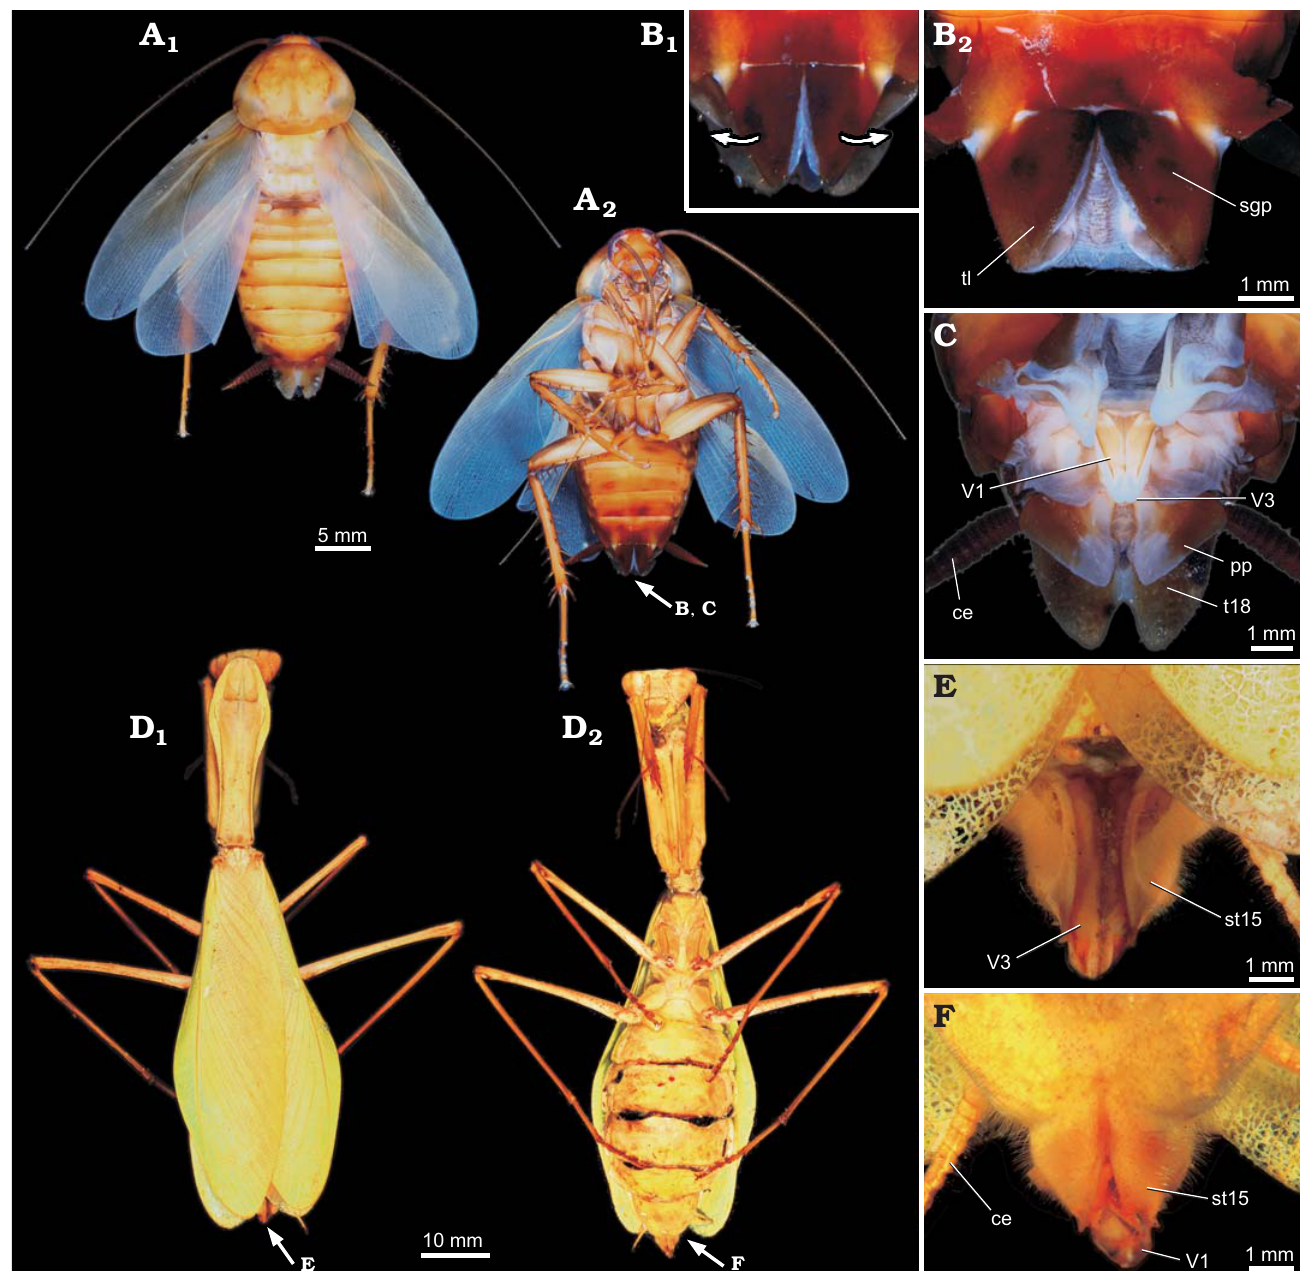
Fig. 1. General external morphology of extant Dictyoptera. A – C . American cockroach Periplaneta americana (Linnaeus, 1758). A . Overview in dorsal (A 1 ) and ventral (A 2 ) views. B . Close-up of subgenital plate in ventral view (B 1 , B 2 ). C . Close-up of the ovipositor, subgenital plate ventrally bent for exposition of the ovipositor valves. D – F . Giant Asian mantis Hierodula cf. grandis (Burmeister, 1838). D . Overview in dorsal (D 1 ) and ventral (D 2 ) views. Close-up of ovipositor in dorsal ( E ) and ventral ( F ) views. Abbreviations: ce, cercus; pp, paraproct; sgp, subgenital plate; st15, sternite of post- ocular segment 15 (abdominal sternite 7; subgenital plate); tl, terminal lobes; t18, tergite of the post-ocular segment 18 (abdominal segment 10); V1, V3, valves 1,